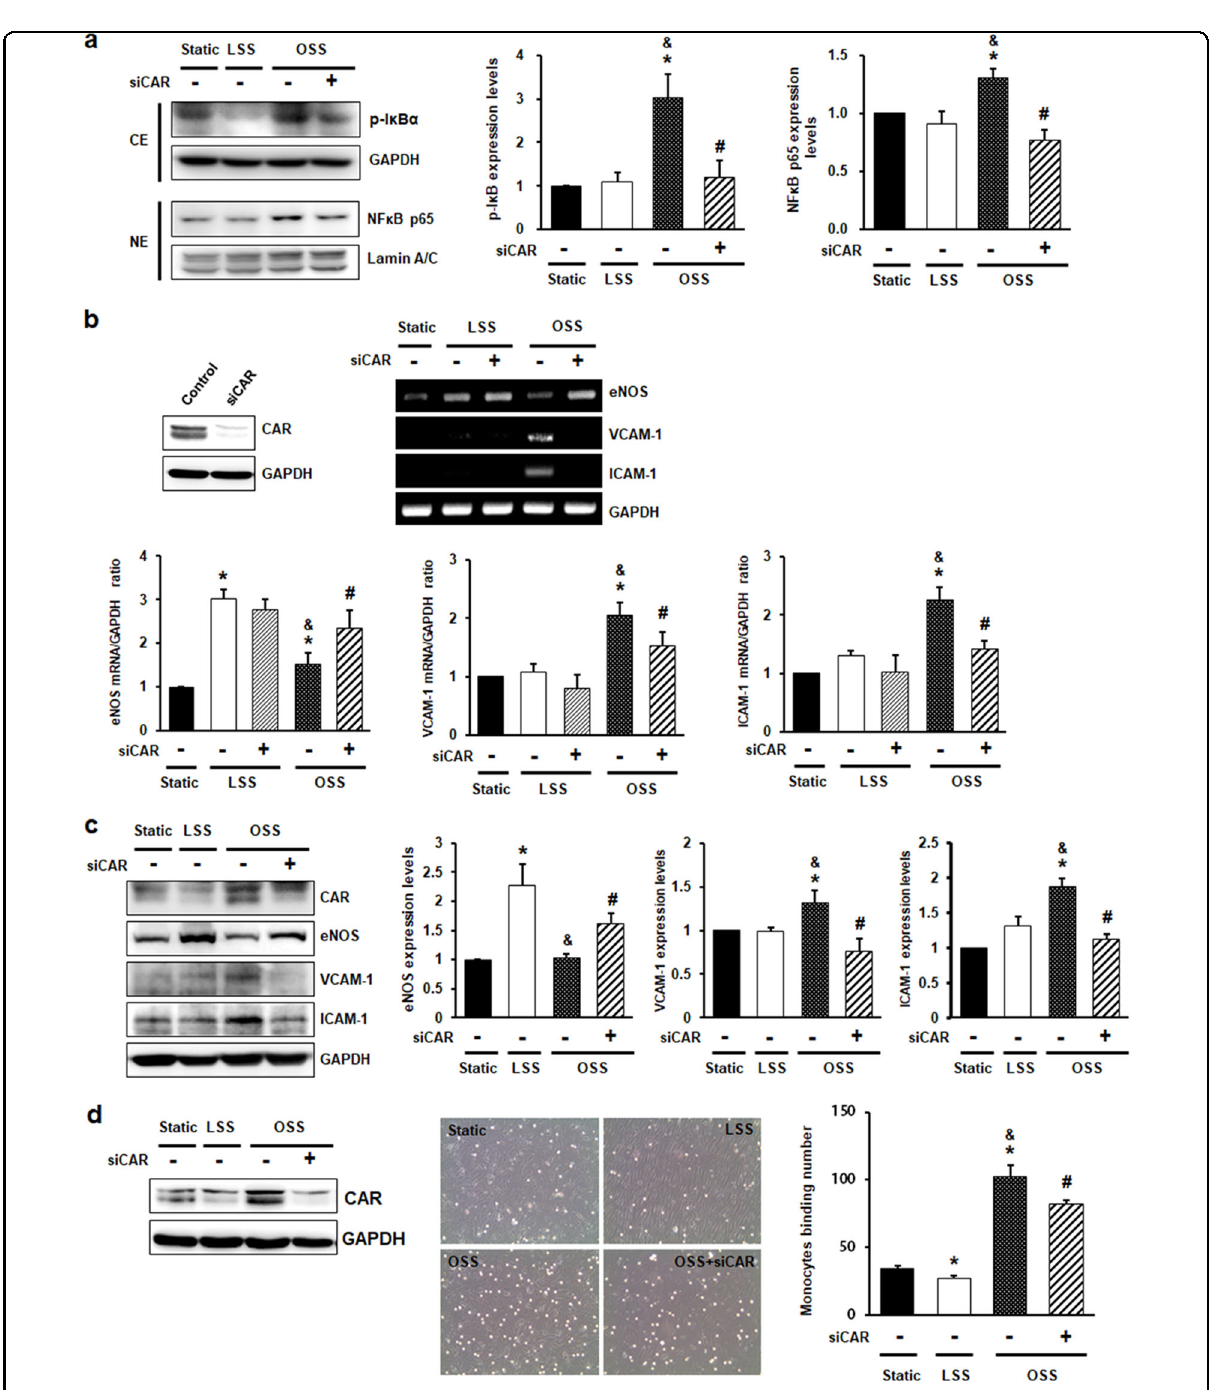
Fig. 3 CAR knockdown inhibits disturbed fl ow-induced in fl ammatory responses in endothelial cells. HUVECs transfected with siRNA against CAR were exposed to FSS for 6h ( b ) or 24h ( a ). a Cytosolic and nuclear fractions were separated after 24h of FSS. The extent of I κ B phosphorylation and nuclear translocation of NF- κ B were determined by western blotting with antibodies against p-I κ B, NF- κ B p65, GAPDH, and Lamin A/C. GAPDH and Lamin A/C were used as loading controls for the cytosolic and nuclear fractions, respectively. Representative images are shown ( n = 5; * P< 0.05, static vs. LSS or OSS; & P <0.05, LSS vs. OSS; # P <0.05, OSS vs. siCAR + OSS). b The knockdown of CAR by siCAR was validated by western blotting. Levels of mRNAs encoding anti-in fl ammatory genes (eNOS), proin fl ammatory genes (VCAM-1 and ICAM-1), and GAPDH (internal control) were measured by RT-PCR. Representative images are shown ( n = 5; * P <0.05, static vs. LSS or OSS; # P <0.05, OSS vs. siCAR + OSS). c The protein levels of eNOS, VCAM-1, and ICAM-1 were measured by western blotting. Representative images are shown ( n = 5; * P< 0.05, static vs. LSS or OSS; & P <0.05, LSS vs. OSS; # P <0.05, OSS vs. siCAR + OSS). d To assay monocyte binding to endothelial cells, we exposed transfected HUVECs to FSS for 24h. Monocytes in fi ve random optical fi elds per sample were counted ( n = 5; * P <0.05, static vs. LSS or OSS; & P <0.05, LSS vs. OSS; # P <0.05, OSS vs. siCAR +